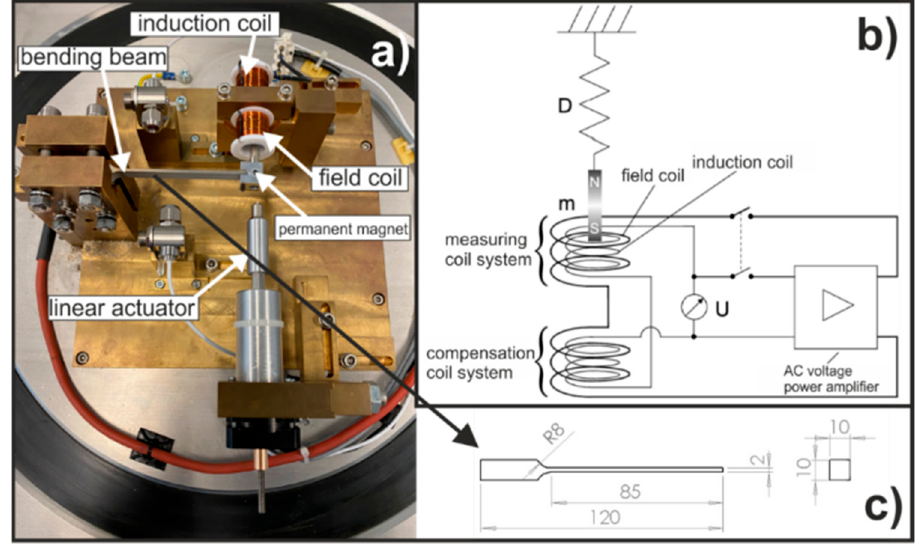
Figure 1. ( a ) Experimental setup of damping measurements; ( b ) schematic representation; ( c ) tech- nical drawing of the sample geometry.